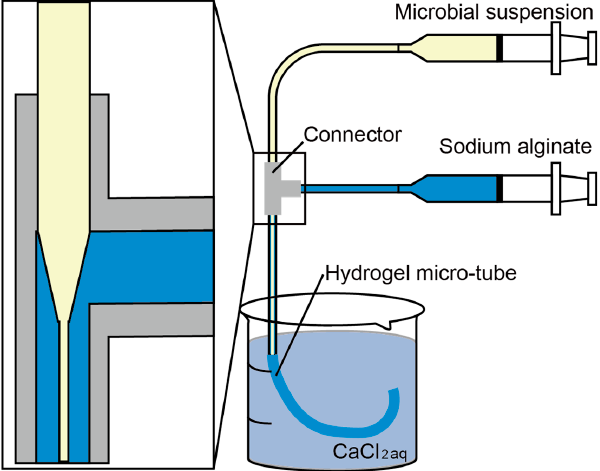
Figure 2. Our previous device with the double-coaxial flow.